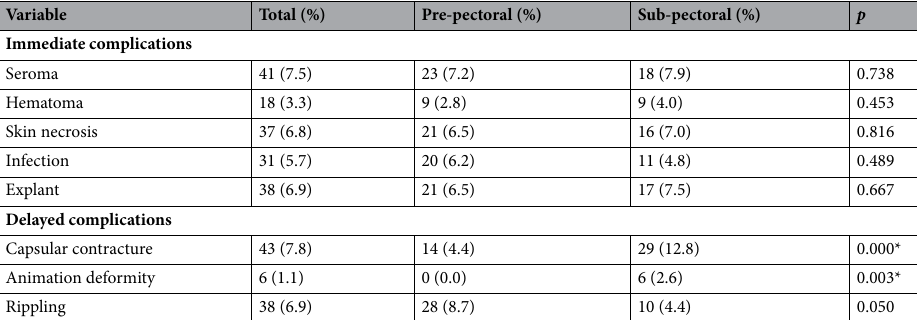
Table 3. Summary of Outcomes. This table examines the surgical outcomes of the index surgery of the both the pre-pectoral implant group and the sub-pectoral implant group. The delayed complications (capsular contracture, animation deformity, and rippling) are the only surgical outcomes that significantly differ between the two cohorts. Continuous variables were analyzed via independent two-tailed t-tests (95% confidence interval) and displayed with standard deviation values. Non-continuous variables were analyzed via Pearson’s chi square. 95% CI. *Statistically significant ( p < 0.05).